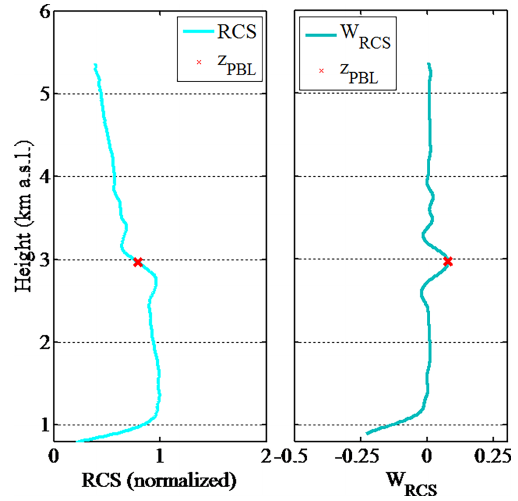
Figure 2. Example of a normalized RCS and its wavelet covariance transform. The red cross indicates the possible location of the PBL